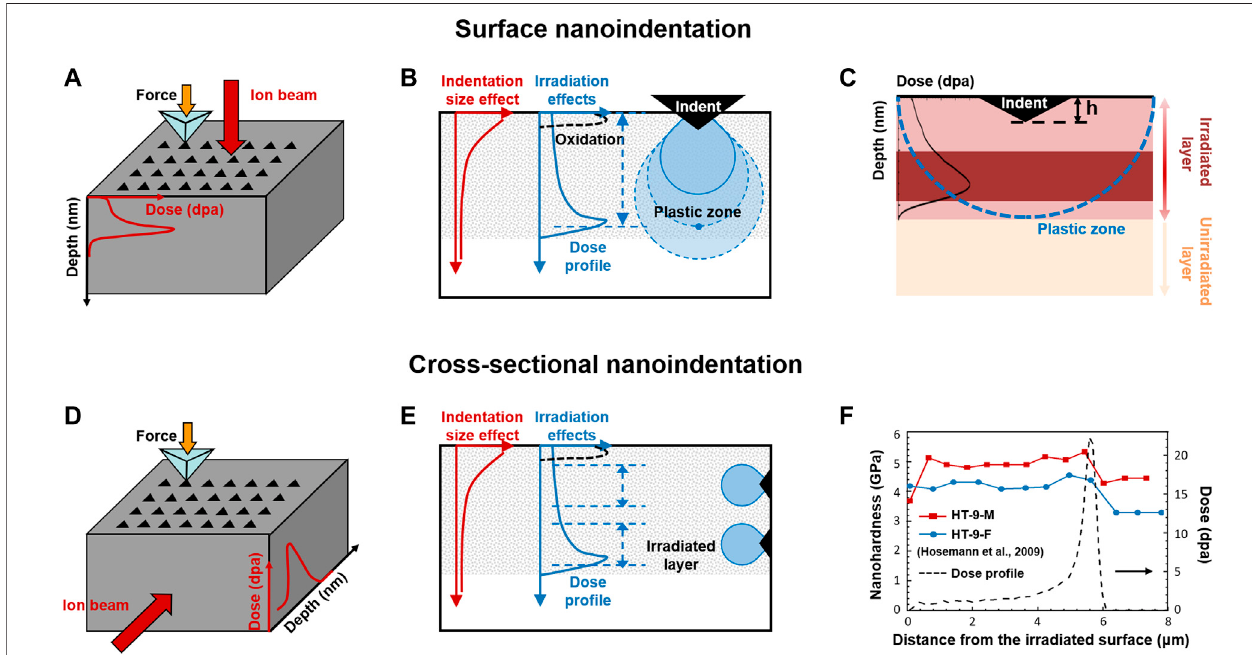
FIGURE2| Schematicdiagramsfor (A) surfacenanoindentationand (D) cross-sectionalnanoindentation,respectively;Theissuesondataanalysesfor (B) surface nanoindentation and (E) cross-sectional nanoindentation; (C) Schematic drawing for the “ simple law of mixture ” ; (F) The damage-dependent hardness for proton- irradiated steels using cross-sectional nanoindentation. Data adapted from Hosemann et al. (2009).